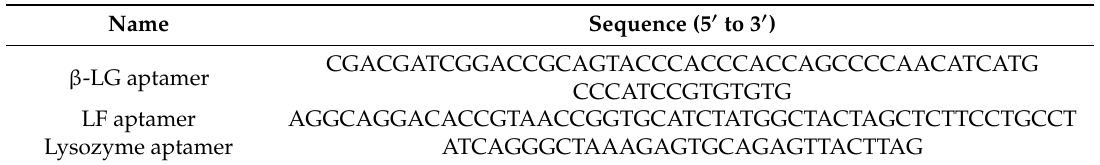
Table 1. List of aptamer DNA sequences used in the study.